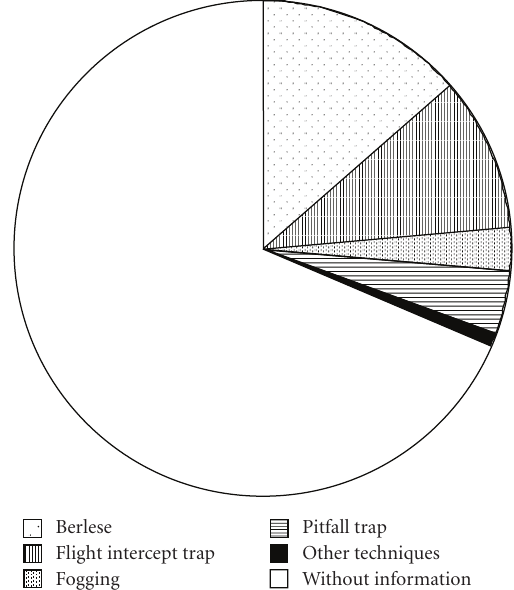
Figure 5: Fraction of specimens caught by di ff erent methods.